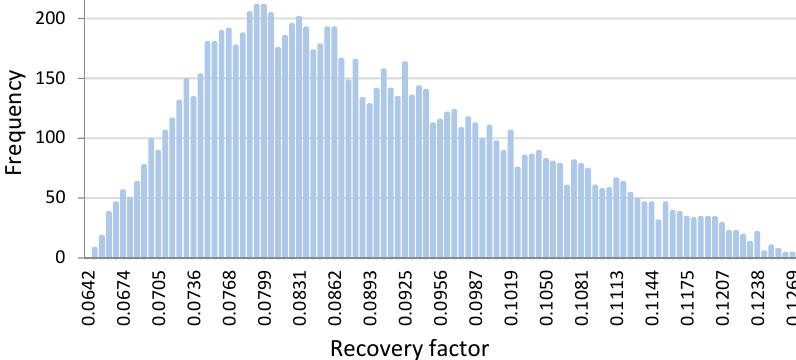
Figure 3. Histogram of the annual recovery factor used in the Monte Carlo method.